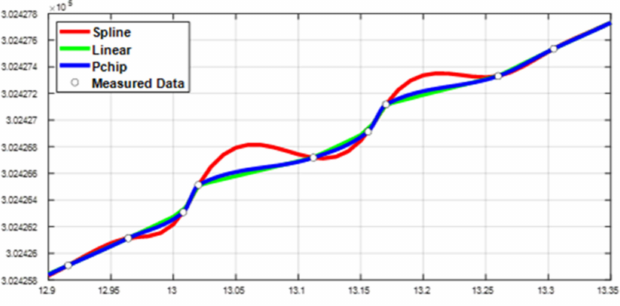
Figure 7. Interpolation result of measured target vehicle